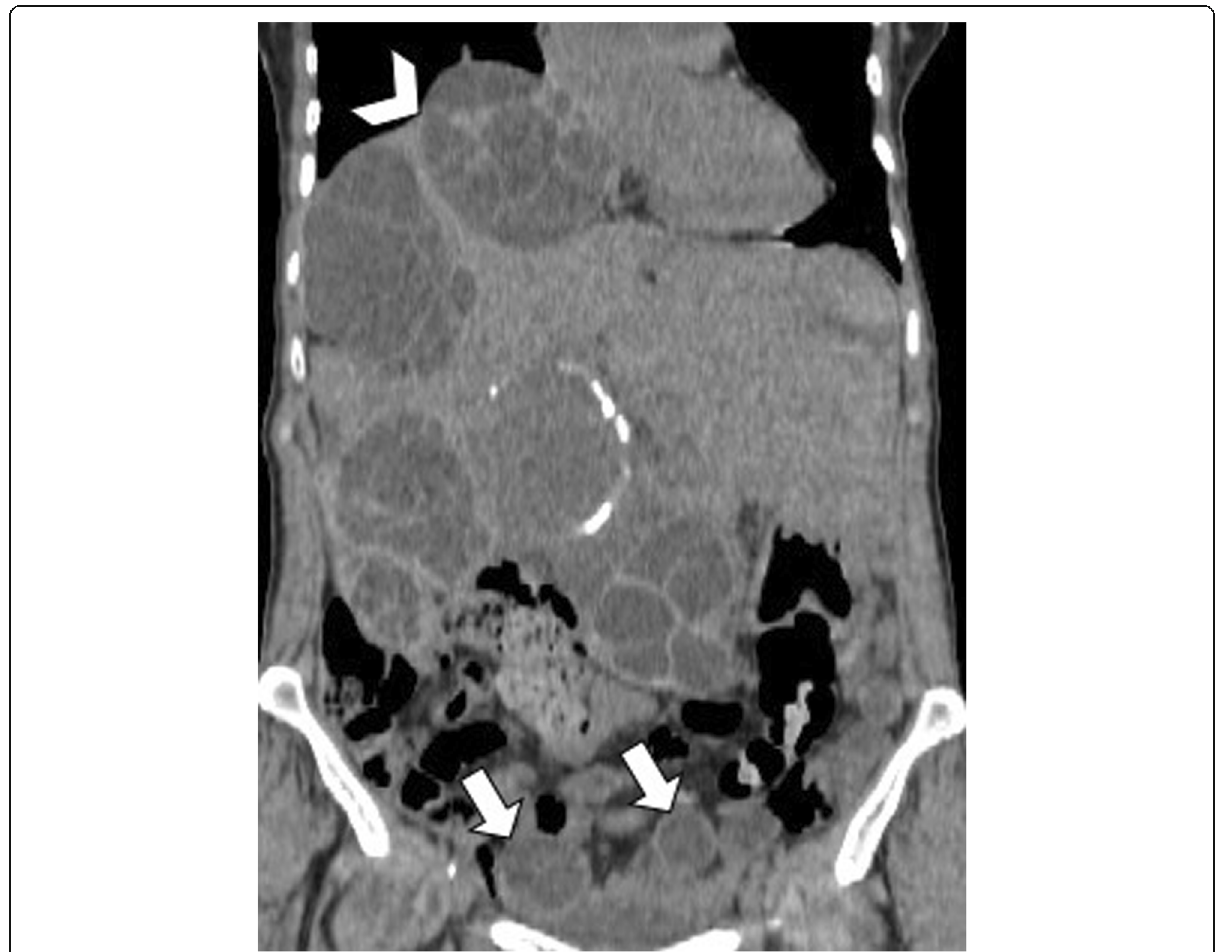
Fig. 9 A 66-year-old woman with diffuse abdominal echinococcosis. Coronal reformatted CT image shows peritoneal dissemination of hydatid cysts (arrows), due to direct rupture of the original liver cysts and compression of the right diaphragm by one of the hepatic hydatid cyst